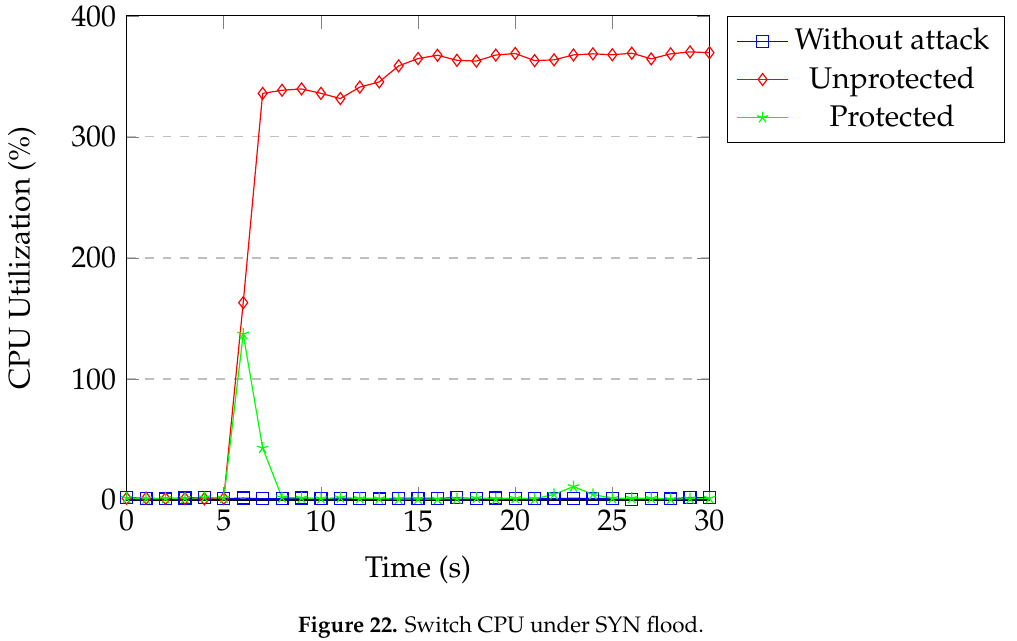
Figure 21. Controller CPU under SYN flood.